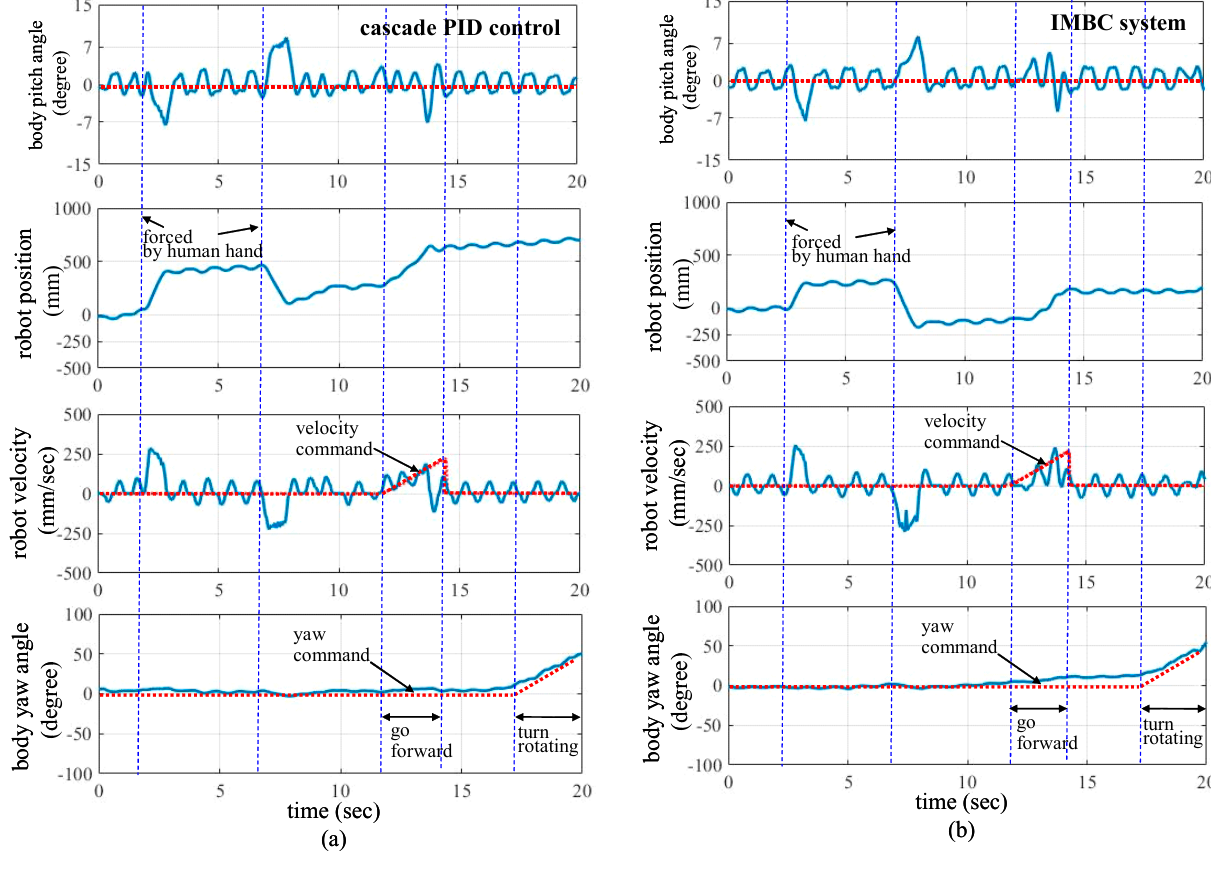
Figure 7. Results of moving and rotating. ( a ) Cascade PID control; ( b ) the IMBC system.